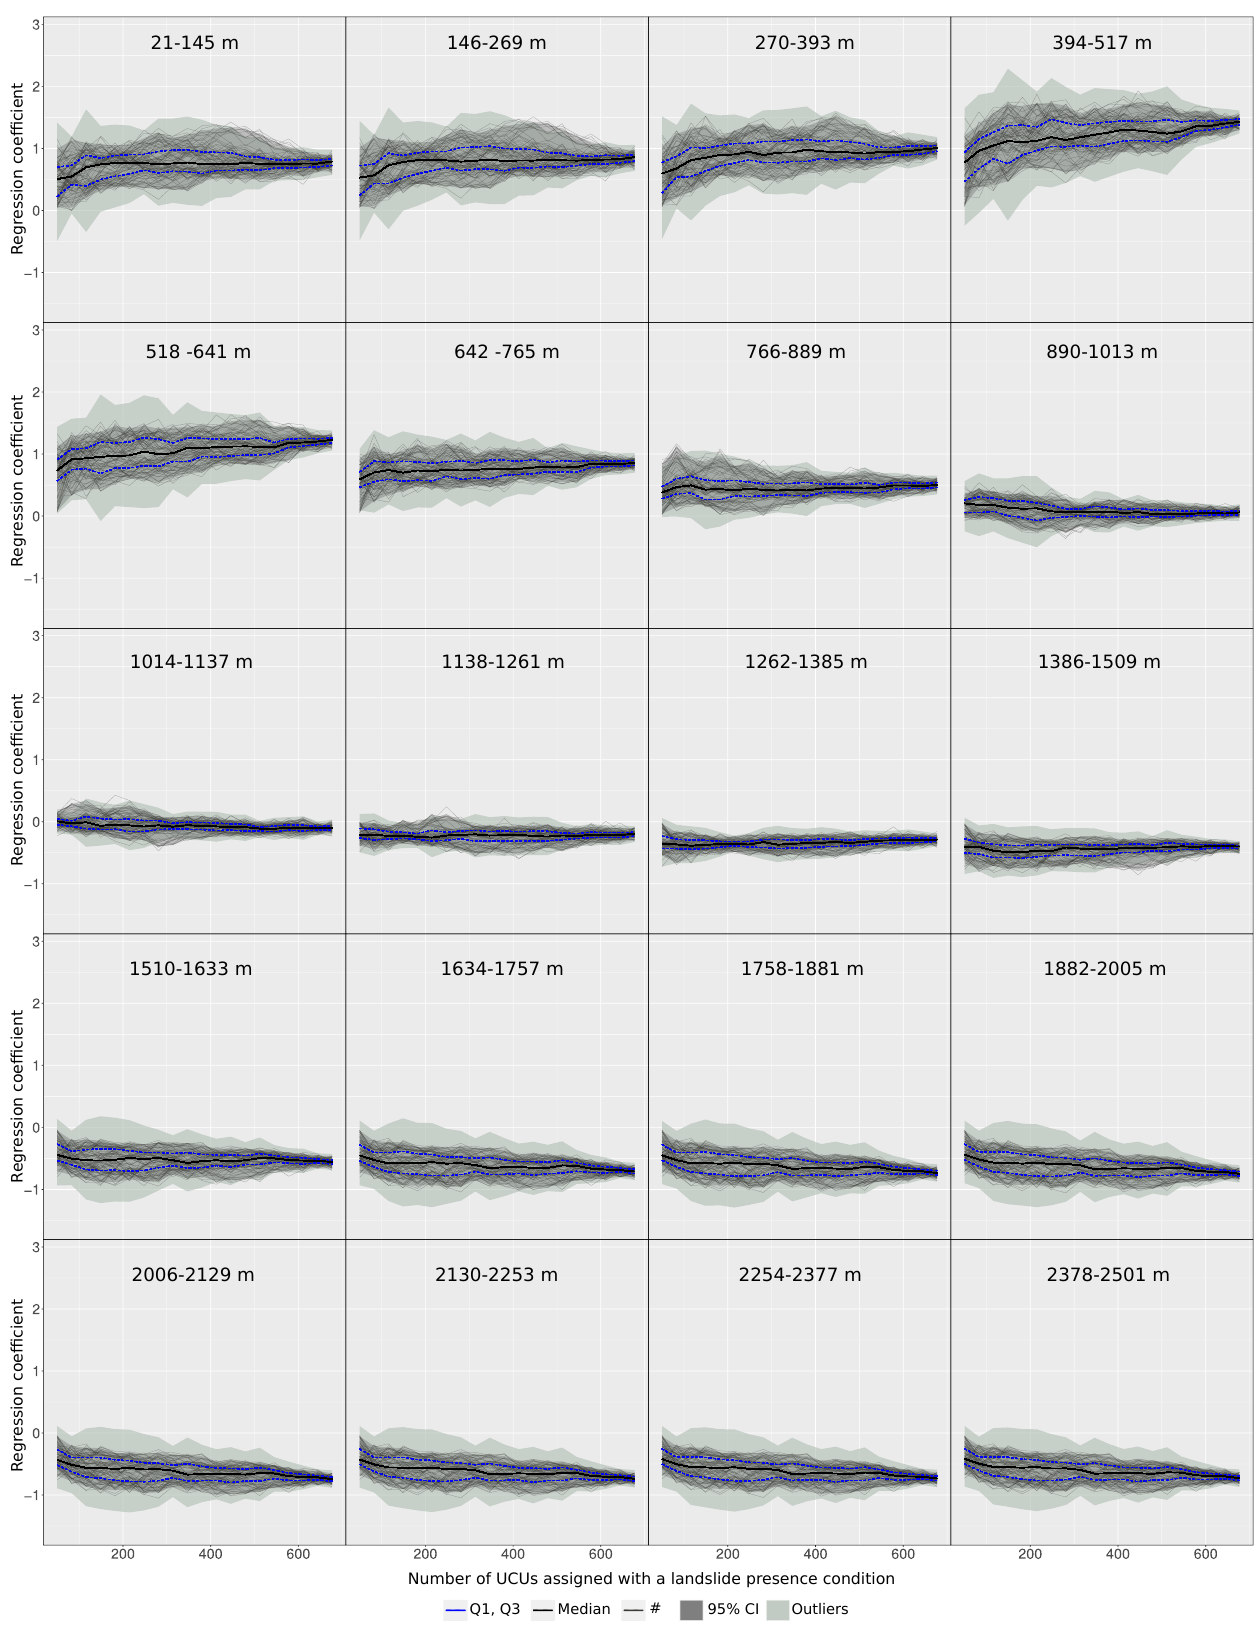
Figure A4. Mean relative relief effect graphical summary at a varying proportion of landslide presence